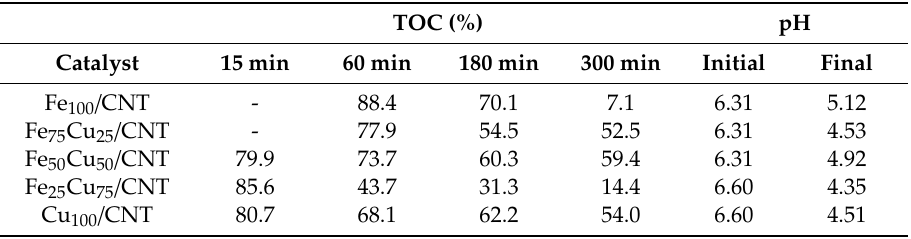
Table 6. Values of total organic carbon (TOC) at di ff erent reaction times and values of pH of the paracetamol solutions before and after reaction. C 0 of paracetamol: 50 mg / L; C 0 of H 2 O 2 : 13.8 × 10 − 3 mol /